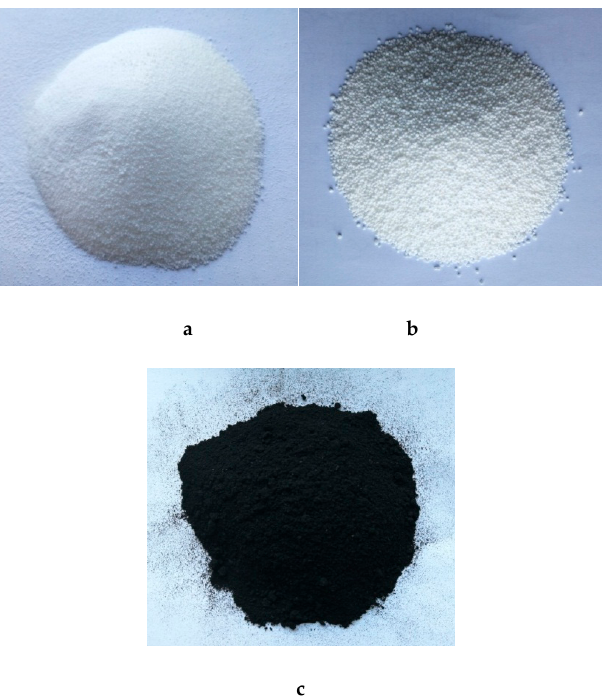
Figure 1. ( a ) Ethylene bis stearic acid amide (EBS); ( b ) stearic acid amide (SA); ( c )